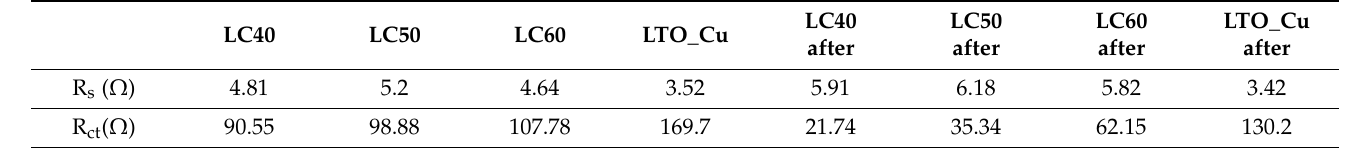
Figure 7. Nyquist impedance plots of the LC40, LC50, LC60 films, and LTO_Cu electrodes after ( a ) making cell and ( b ) 20th charge at 0.5 C, measured in the frequency range of 0.01 Hz–1 MHz (Z’: real part of impedance; Z”: imaginary part of impedance). Table 1. Physical properties and electrochemical impedance spectroscopy parameters of the LC films and LTO_Cu electrodes.